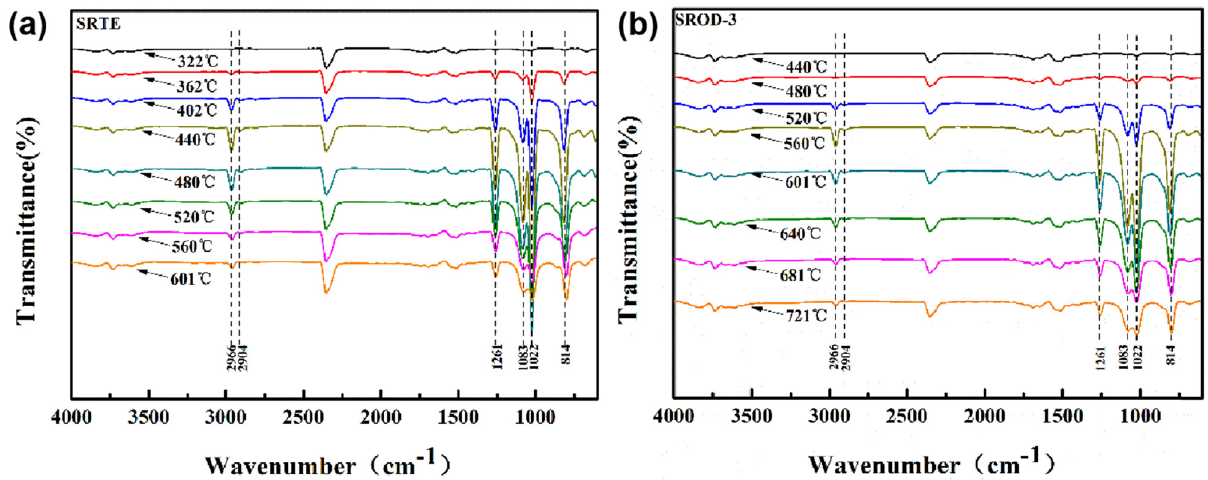
Figure 9: Real - time FTIR spectra of the ( a ) SRTE and the ( b ) SROD - 3 sample thermal degradation ( conditions: 10°C · min − 1 and N 2 atmosphere )